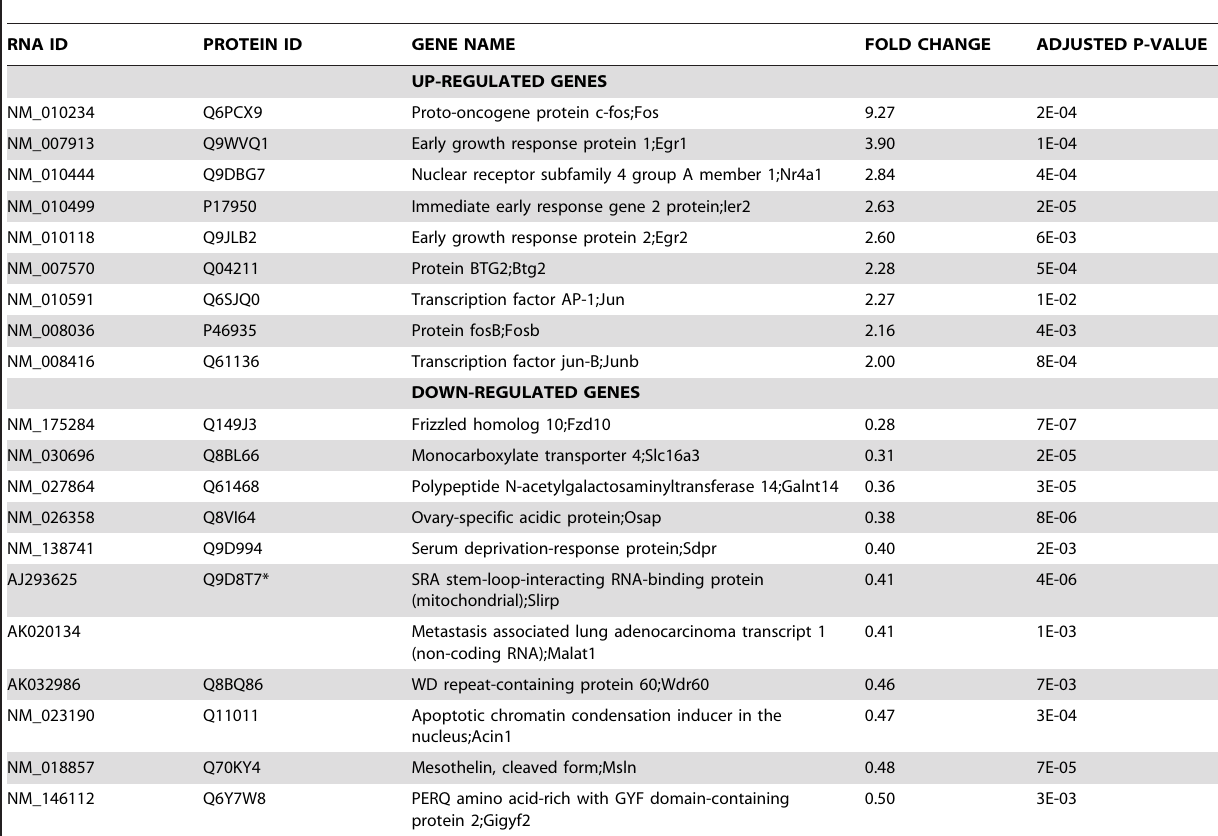
Table 1. Results from DNA microarray analysis: gene expression levels in compressed samples were compared to uncompressed control samples (fold change . 2 and p-value . 0.01).